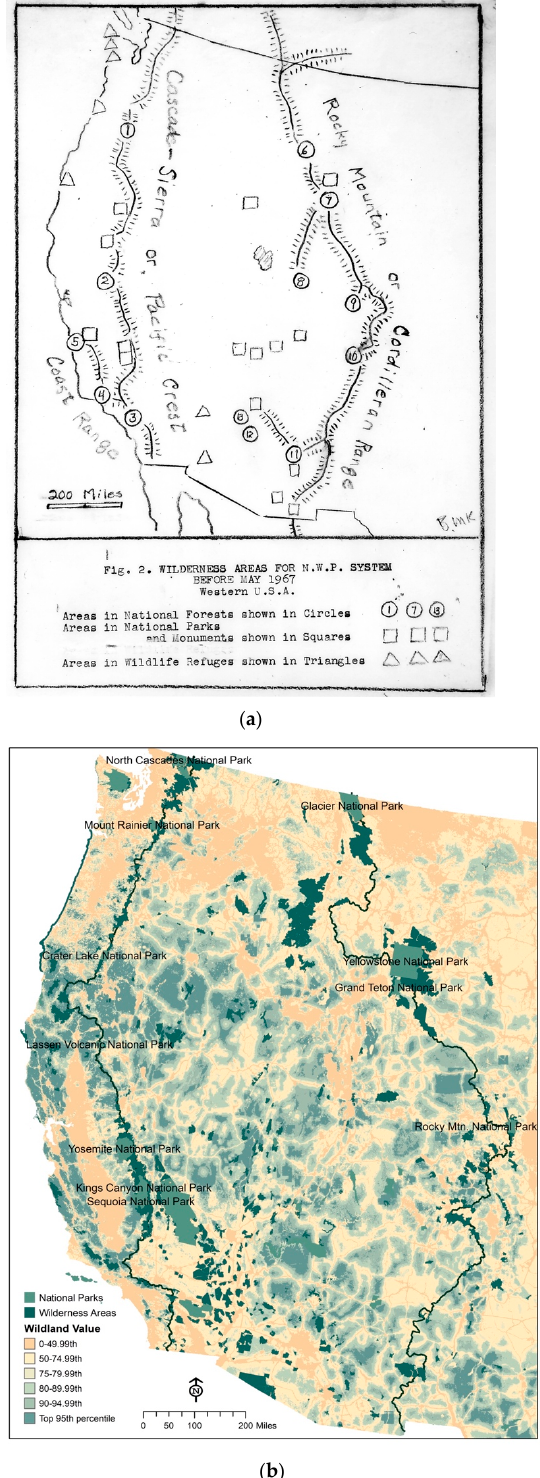
Figure 5. ( a ) Modeled potential protected area network by Benton MacKaye in 1966 [20]. ( b ) Modeled potential area network using the PCT and CDT as wildlife corridors in the American West.